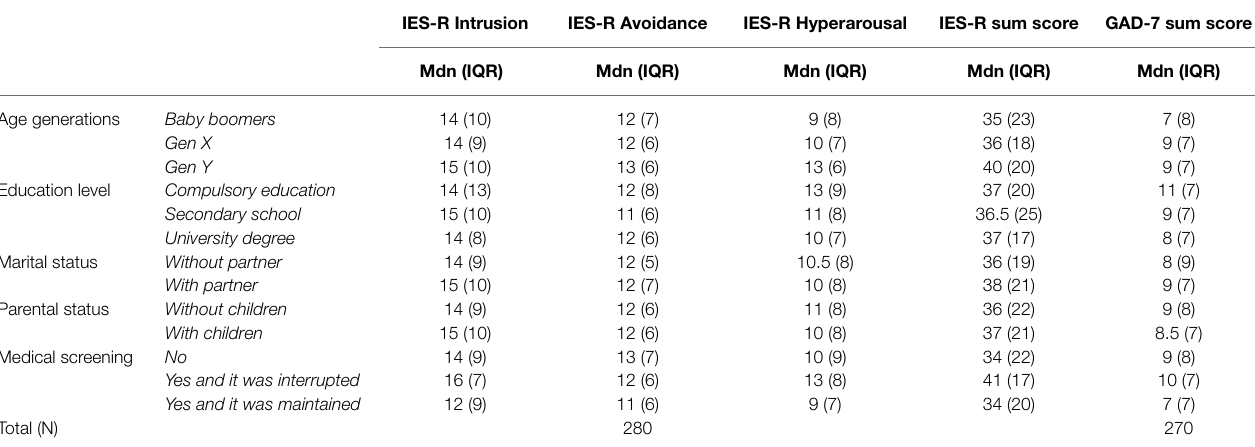
TABLE 2 | Median and (interquartile range) values for IES-R and GAD-7